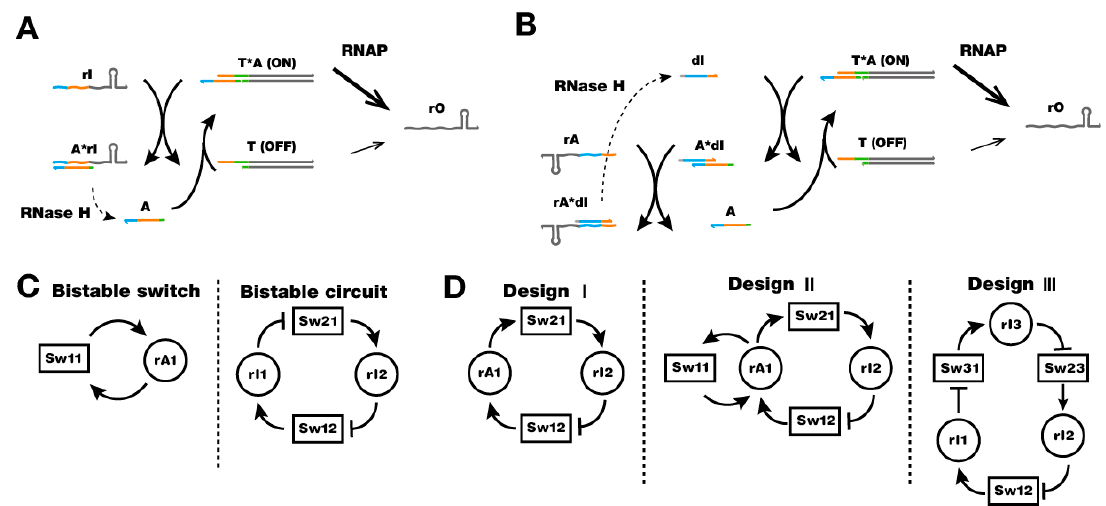
Figure 3. Genelet switches and circuits. ( A ) Design and operation mechanism of an inhibitable switch. The input, RNA inhibitor, sequesters the DNA activator from the active template and turns the switch to an OFF state. ( B ) Design and operation mechanism of an activating switch. The input, RNA activator, strips o ff DNA inhibitor bound to DNA activator. The released DNA activator in turn can turn the switch to an ON state. The sequence domains are color coded to indicate identical or complementary sequences. ( C ) Schematics of bistable circuits. A single switch with positive autoregulation (left) or two mutually inhibiting switches (right) can show bistability. ( D ) Schematics of oscillators. An activating switch and an inhibiting switch (Design I), Design I with further positive-autoregulation (Design II), and three inhibiting switches in a ring (Design III) form an overall negative feedback to achieve oscillation. Reproduced with permission from [15,16].